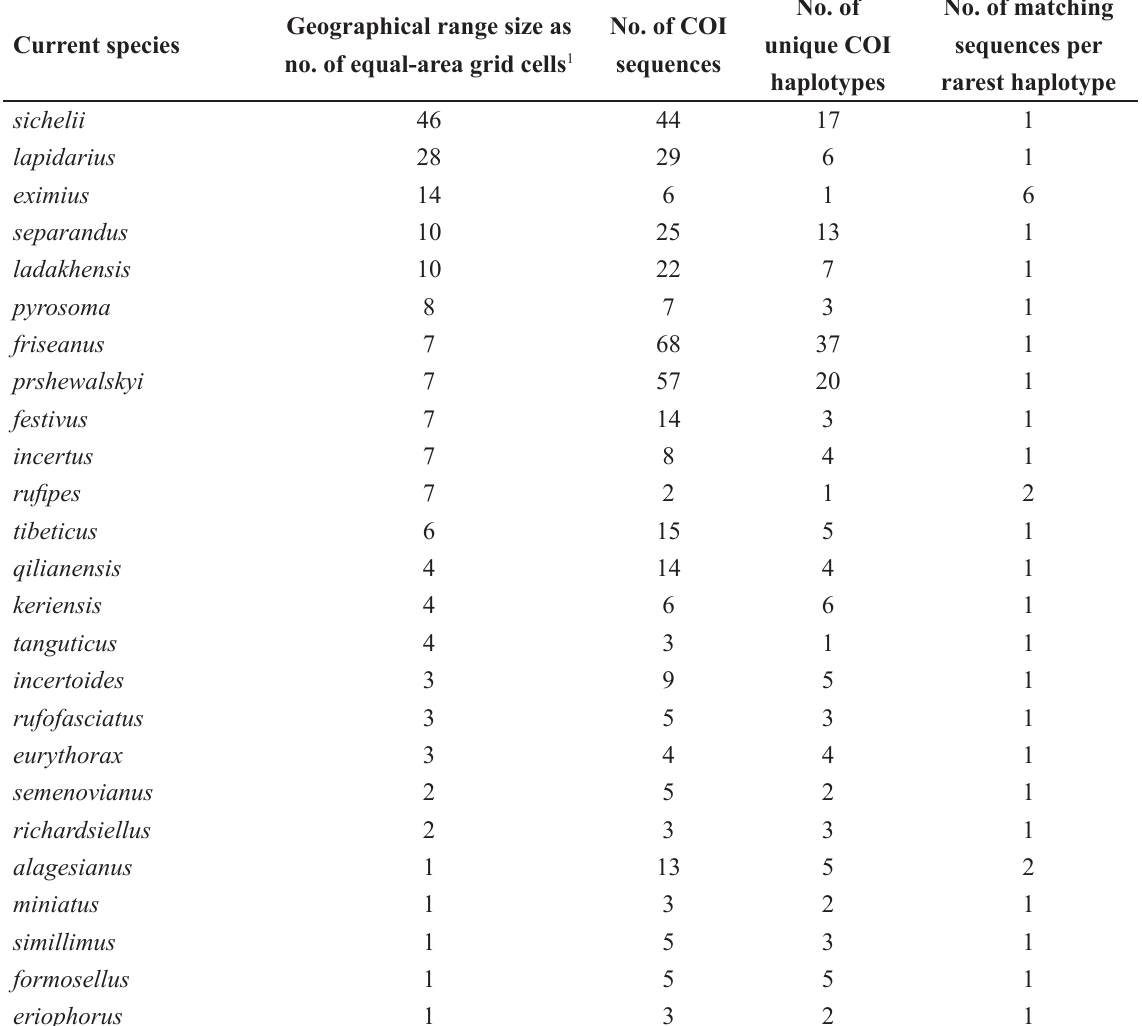
Table 6. Sampling of the species as currently recognized from integrative